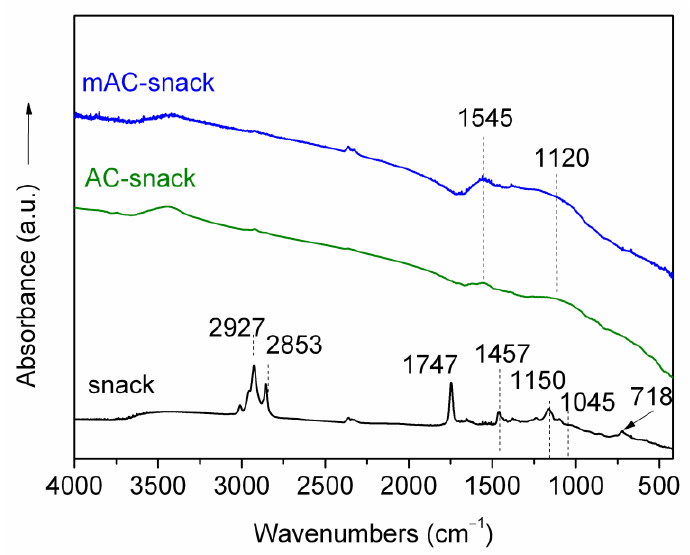
Figure 4. FTIR spectra of AC-snack and mAC-snack samples in comparison with the spectrum of initial snack.